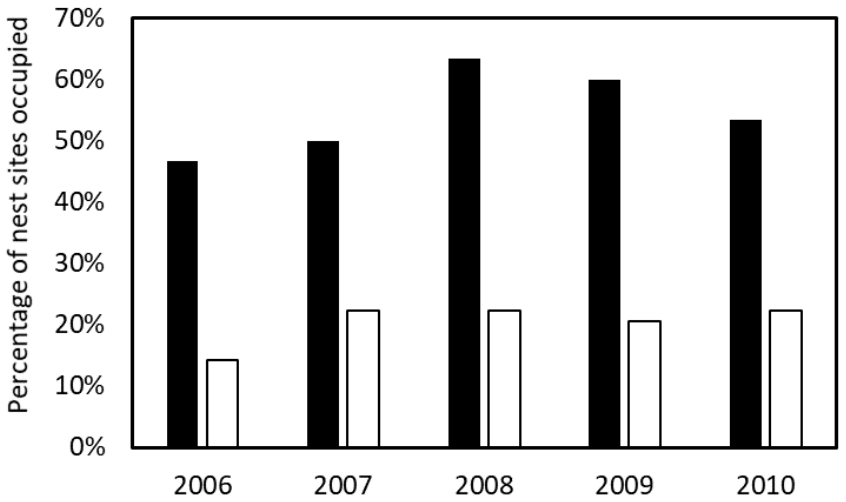
Figure 2. The number of fledglings of the eagle owl ( Bubo bubo ) during the years 2006–2010 in the Judea region of central Israel.